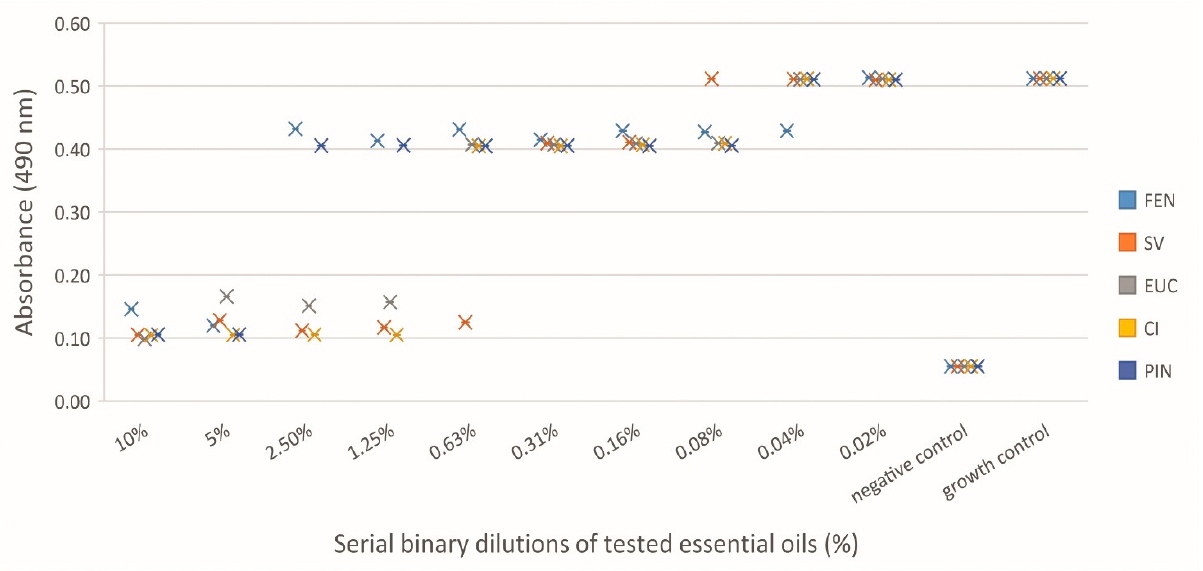
Figure 10. Graphical representation of the MCBE values for Gram-negative strain Escherichia coli ATCC 25922; FEN (fennel EO); SV (sage EO); EUC (eucalyptus EO); CI (thyme EO); PIN (pine EO).